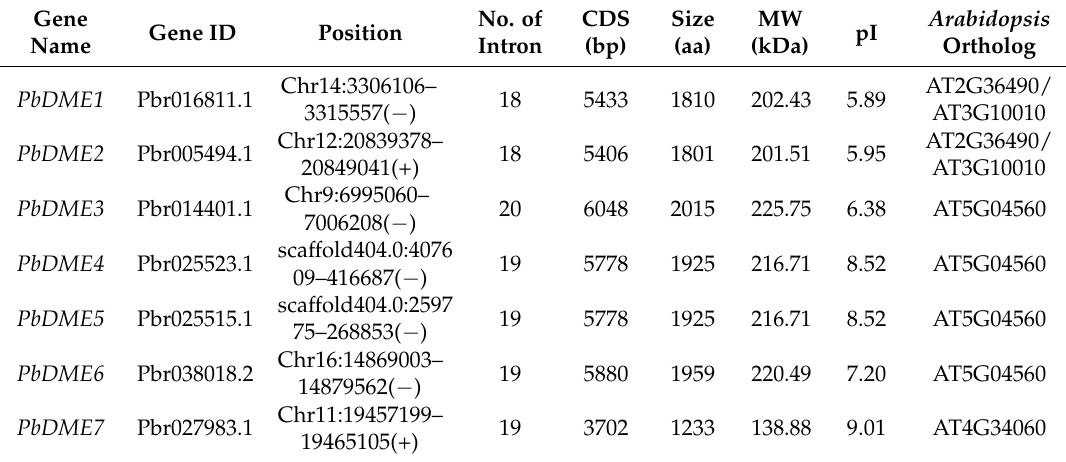
Table 1. The characteristics of demethylase (DME) family members in